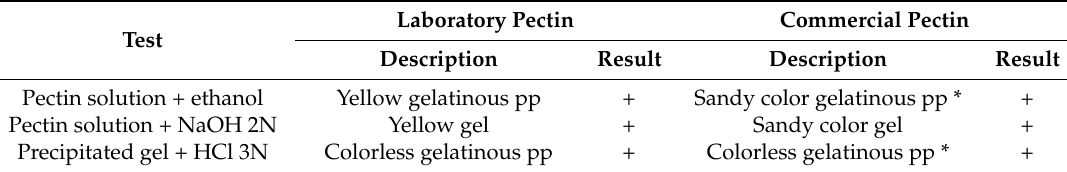
Table 4. Qualitative tests for the identification and conformation of pectin. Laboratory Pectin Commercial Pectin Test Description Result Description Result Pectin solution + ethanol Yellow gelatinous pp + Sandy color gelatinous pp * + Pectin solution + NaOH 2N Yellow gel + Sandy color gel + Precipitated gel + HCl 3N Colorless gelatinous pp + Colorless gelatinous pp * + * pp: precipitate.